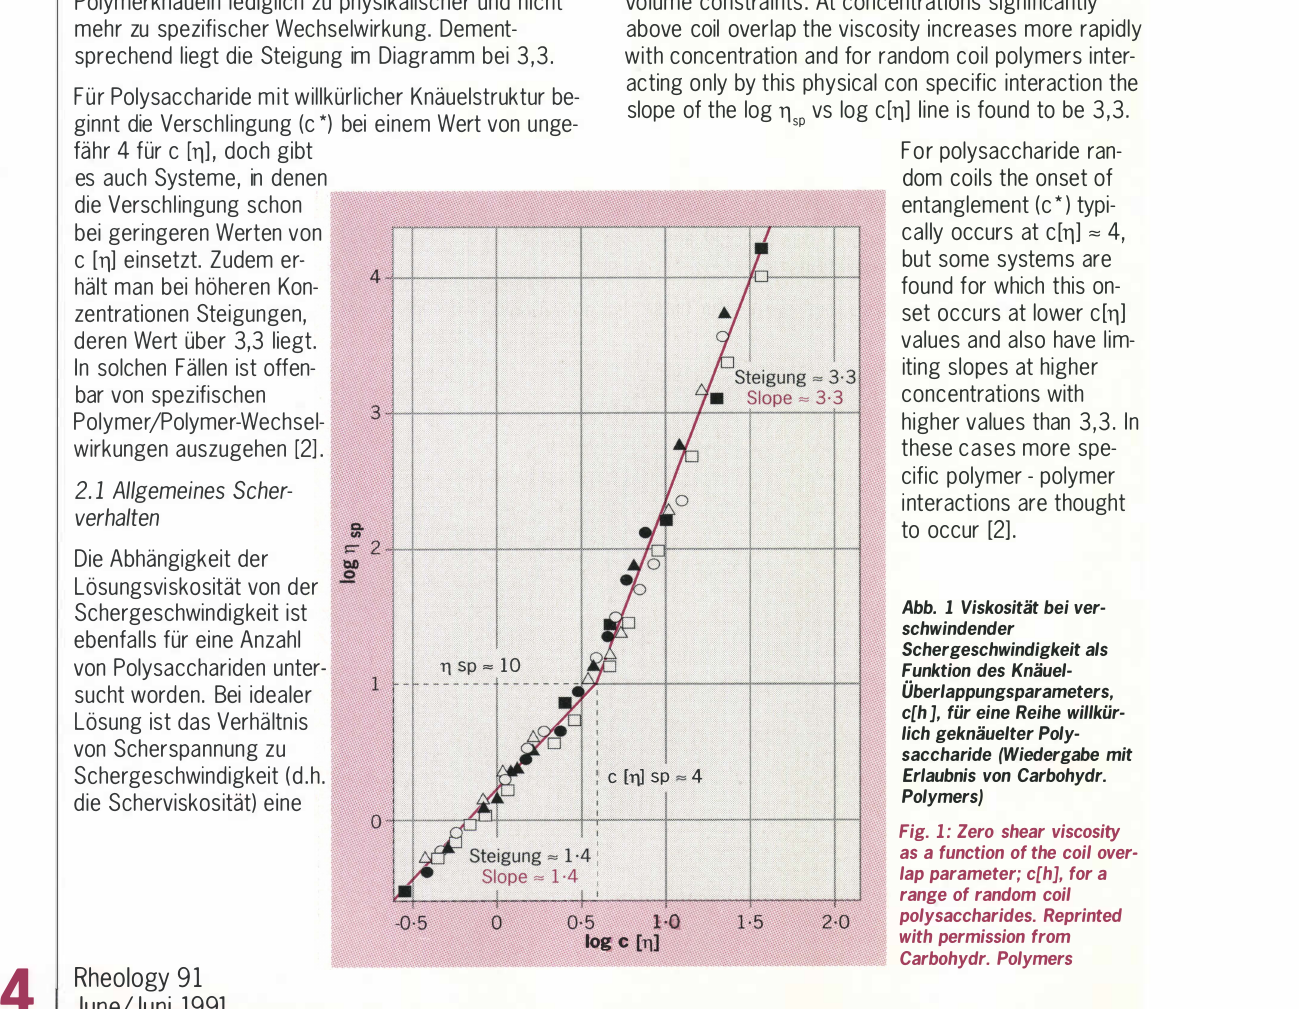
Fig. l: Zero shear viscosity as a function of the coil over­ lap parameter; c[h], for a range of random coil polysaccharides. Reprinted with permission from Carbohydr. Polymers